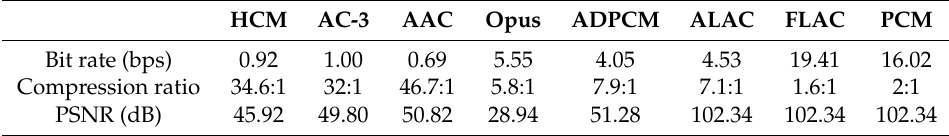
Table 5. Results for Non-linear 6 dataset. Bit rates taken as close as possible to 50dB. HCM AC-3 AAC Opus